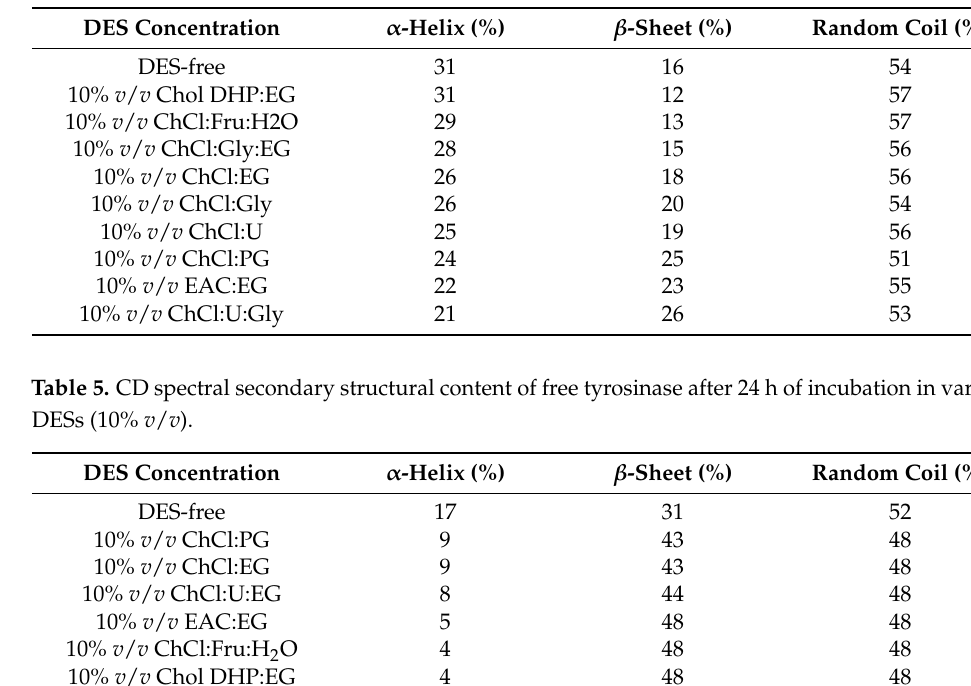
Table 4. CD spectral secondary structural content of free tyrosinase after 5 min of incubation in various DESs (10% v / v ).